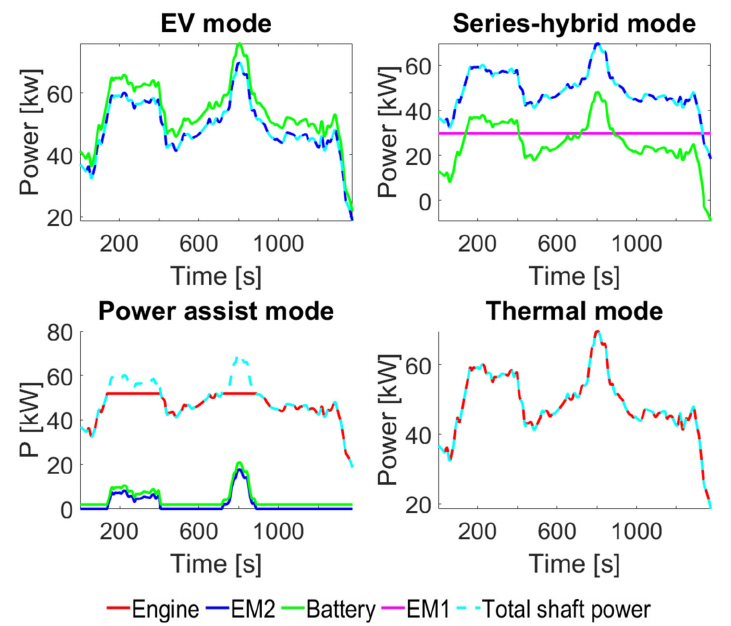
Figure 9. Distribution of power among the di ff erent components of the power system.